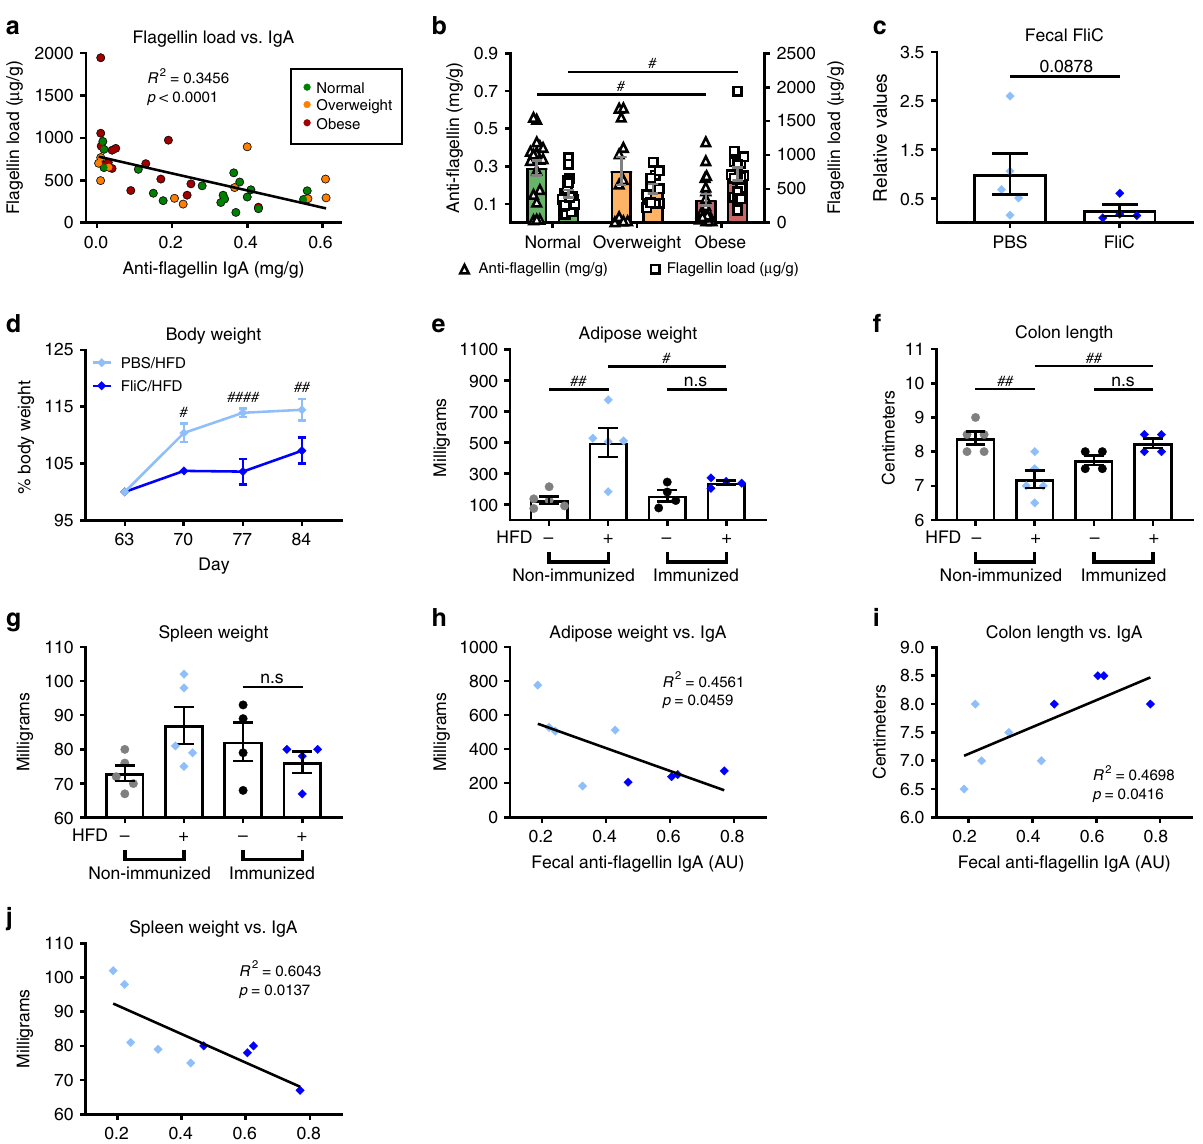
Fig. 7 Flagellin immunization protected against high-fat diet-induced obesity. a Flagellin load ( y axis) inversely correlate with anti- fl agellin IgA concentration ( x axis) in humans. R2 represents the coef fi cient of determination. b Mean concentration ± S.E.M. of fl agellin load and anti- fl agellin IgA concentration for human subjects segregated by their BMI to normal (18.5 – 24.9, N = 17), overweight (25 – 29.9, N = 11) or obese (> 30, N = 15). Flagellin concentration is denoted on the left y axis and anti- fl agellin IgA concentration is denoted on the right y axis. # P < 0.05; one-way analysis of variance (ANOVA). c – j 8-week old, C57BL/6 J mice were purchased from The Jackson Laboratory and housed for two weeks before procedure in order to favor microbiota stabilization. Subsequently, fl agellin (10 μ g per mouse) was administered by intraperitoneal injections weekly for 9 weeks, whereas control mice received vehicle (PBS). Subsequently, animals were treated with high-fat diet (60% kcal from fat) for 4 weeks. c Fecal fl agellin quanti fi ed using HEK 293 cells expressing mTLR5. d Body weights were measured weekly and expressed as relative values, day 63 (post immunization, pre high-fat diet treatment) being de fi ne as 100%. e Adipose weight. f Colon length. g Spleen weight. h – j Day 63 fecal anti- fl agellin IgA correlated with adipose and spleen weights, as well as, colon length. Data are the means ± S.E.M. Signi fi cance was determined using linear regression analysis (for h , p values shown), t